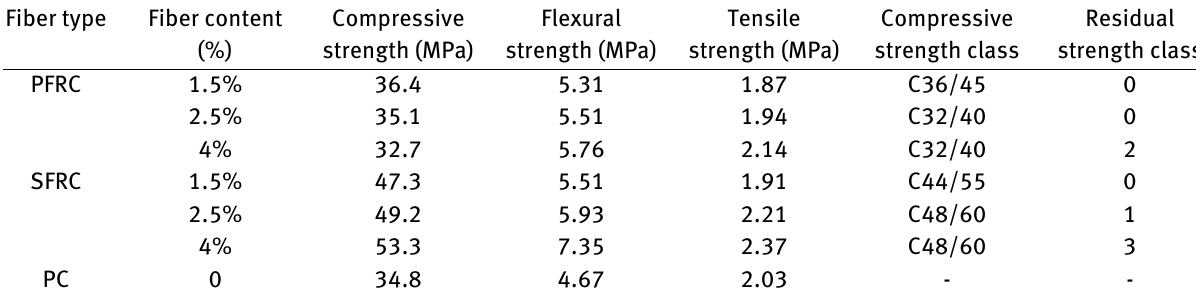
Table 4: The results obtained from the tests conducted in this study Fiber type